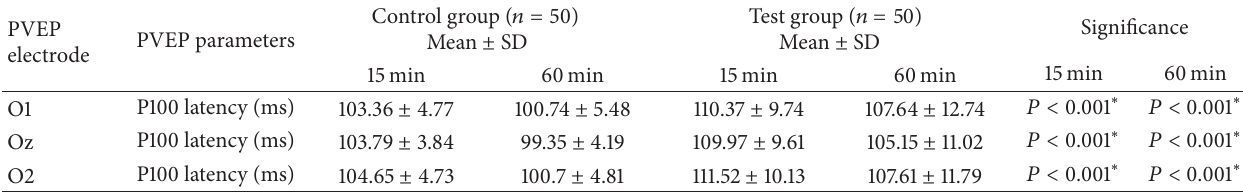
Table 1: PVEP values in the test group and the control group (Student’s 𝑡 -test, 𝑛 : number of eyes). PVEP electrode